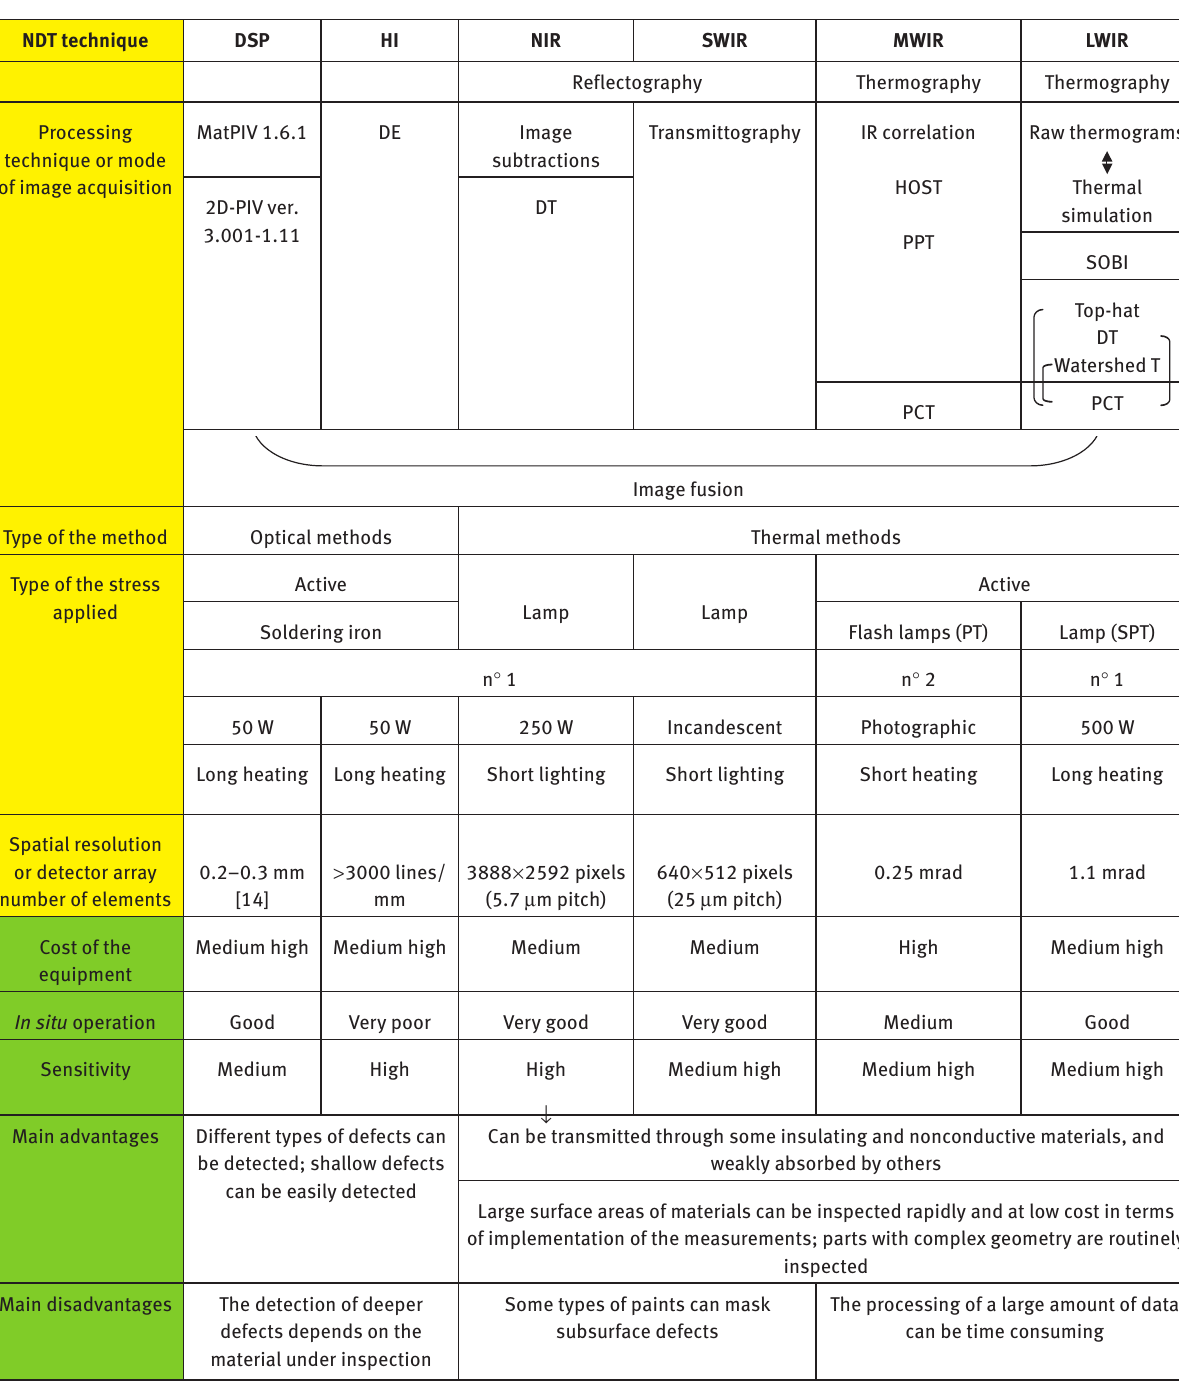
Table 1 Fundamental technical information (yellow background), advantage, and disadvantage (green background) of the NDT methods